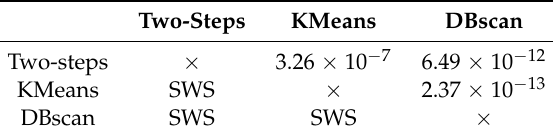
Table 17. p -values for instance nrg.5.